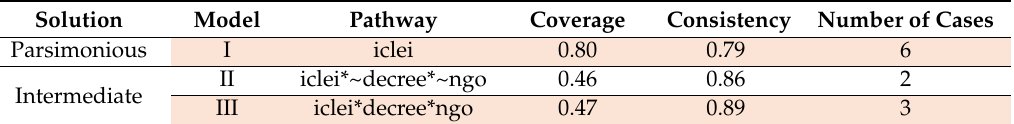
Table 4. Pathways for solar PV generation.